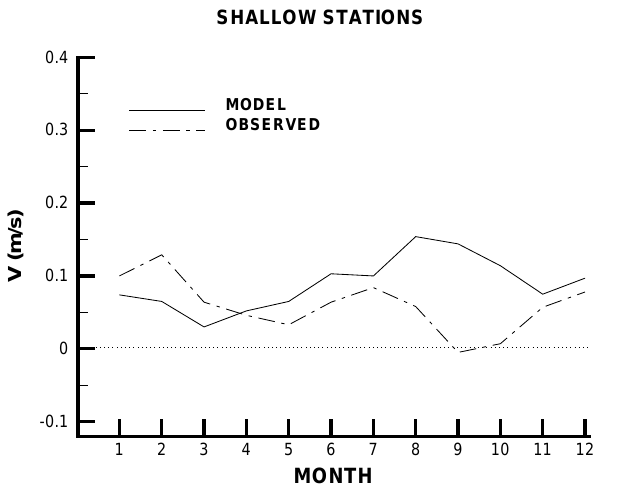
Fig. 14. Seasonal cycle of the year 3 simulated (solid line) and multiyear observed (dash-dot line) monthly mean currents at the shallow stations (current meter depth 18m; water depth 26m).